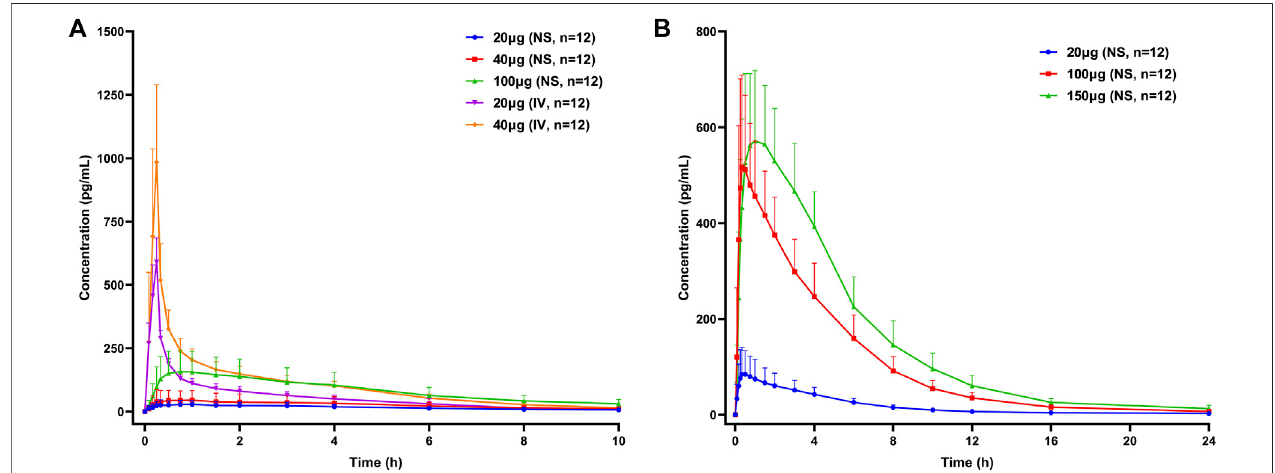
FIGURE1| Meanconcentration – time curves ofdexmedetomidineinhealthysubjectsfollowingasingledose ofdexmedetomidinenasal sprayorinjection. (A) Part 1, (B) Part 2, and Part 3. NS, nasal spray; IV, intravenous.